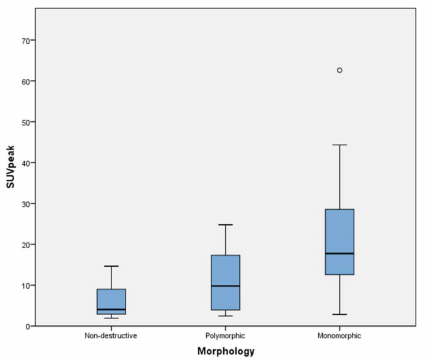
Figure 2. Box-plot distribution peak standard uptake value (SUV peak ).